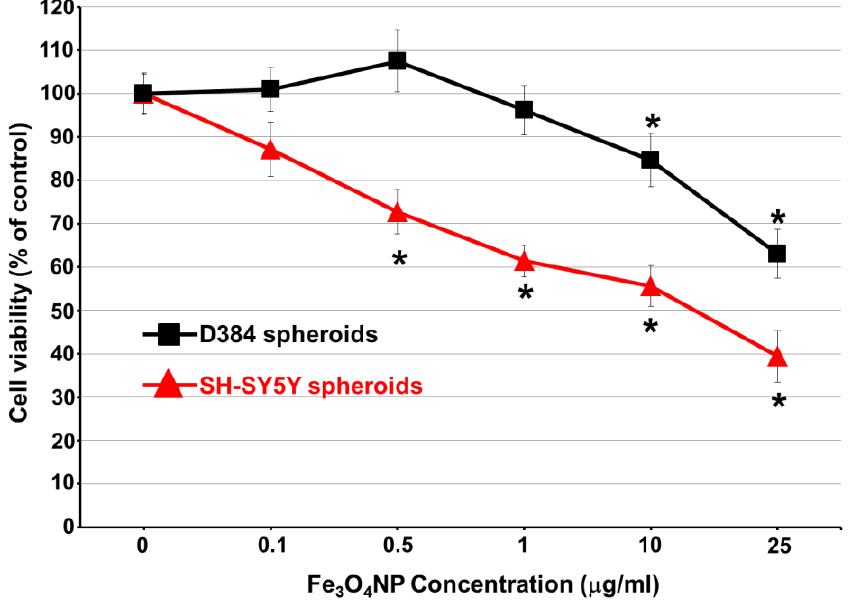
Figure 6. Cell viability evaluation in astrocyte and neuronal spheroids after long-term exposure to Fe 3 O 4 NPs. Dose-response curves of cell viability evaluated by trypan blue test. Astrocyte and neuronal spheroids were repeatedly treated with various low concentrations of Fe 3 O 4 NPs (0.1, 0.5, 1, 10, 25 µ g/mL). Data are expressed as percentage of viable cells in treated cultures taking as 100% the number of viable cells in control condition and represent the mean ± S.D. * p < 0.05, statistical analysis by two-way ANOVA followed by Dunnett’s test.